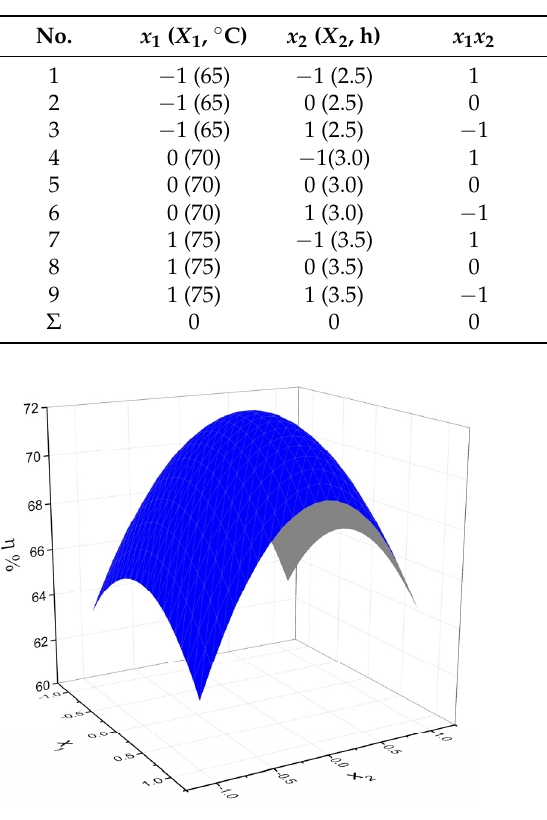
Table 3. E xperiment 3 2 for molecule X.